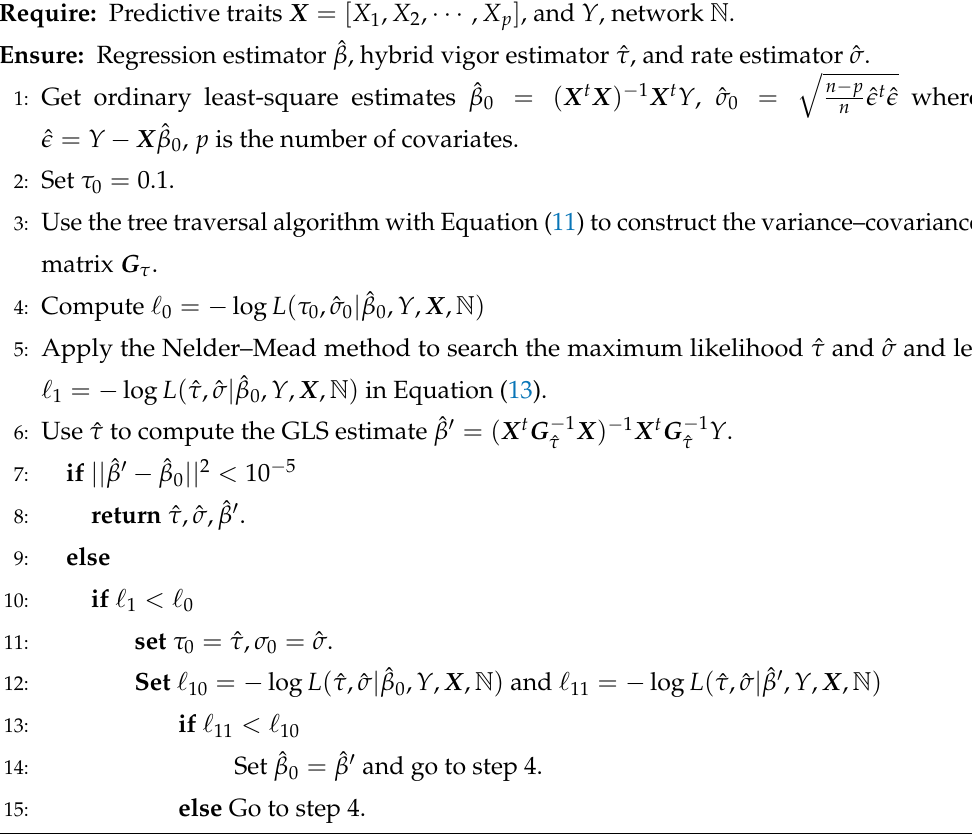
Algorithm 1 Procedure for Parameter